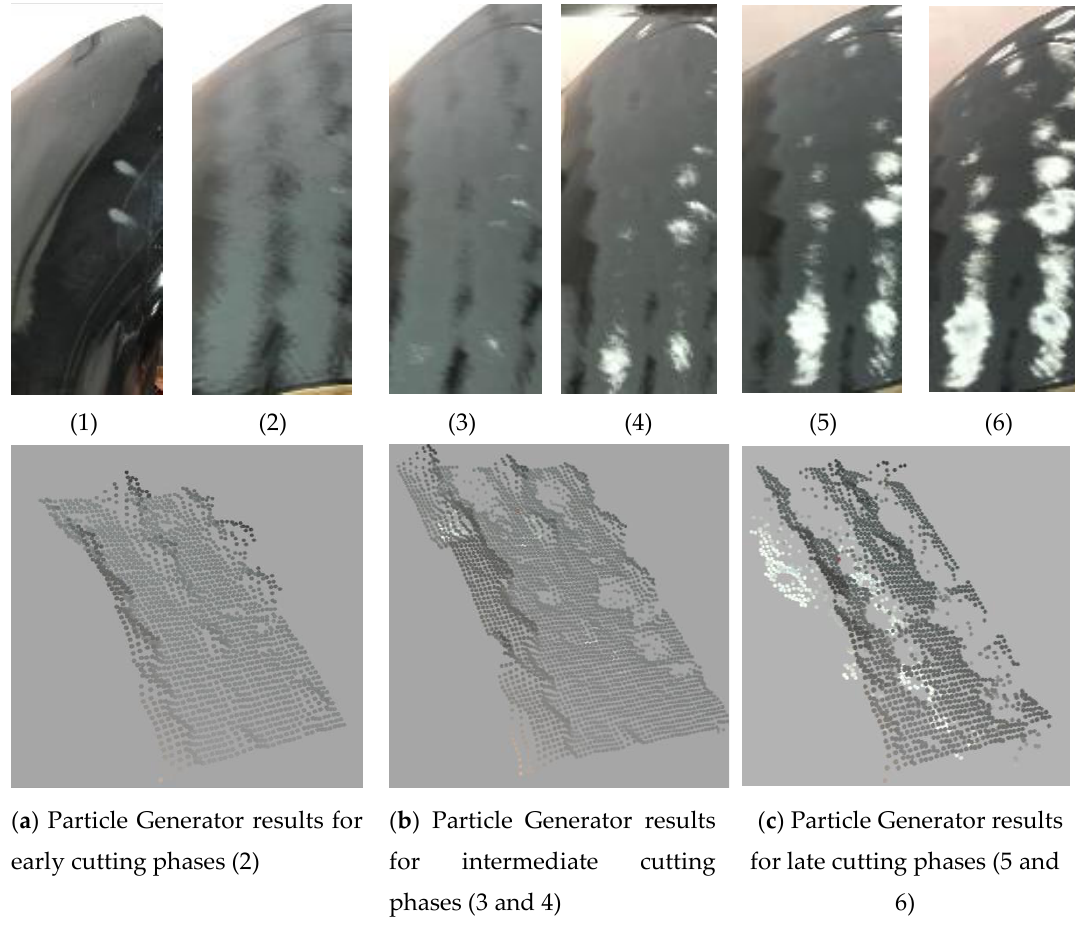
Figure 15. Progress of the proposed automated grinding cell. First row shows the effects of the grinding end-effector on the fan-blade surface while the second row shows the digitized surface using the particle generator (Section 2.3).